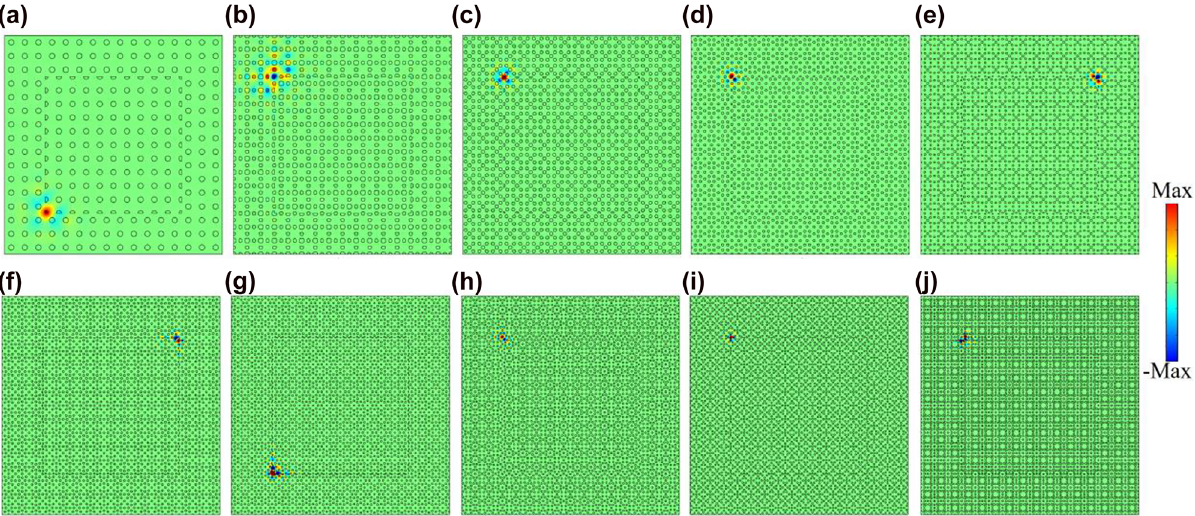
Figure6: EigenfielddistributionsofonerepresentativecornerstatelabelledbyC n inFigure5.(a)C1,(b)C3,(c)C5,(d)C7,(e)C9,(f)C11,(g)C13, (h) C15, (i) C17, and (j) C19.